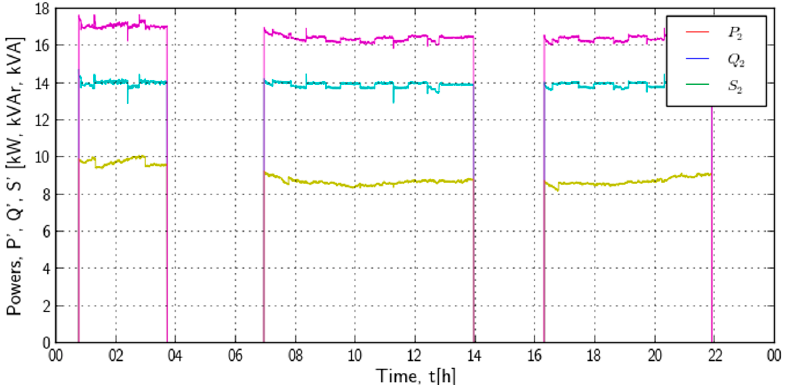
Figure 5. The diagrams of the PU2 active, reactive, and apparent power changes on 30 December 2009.